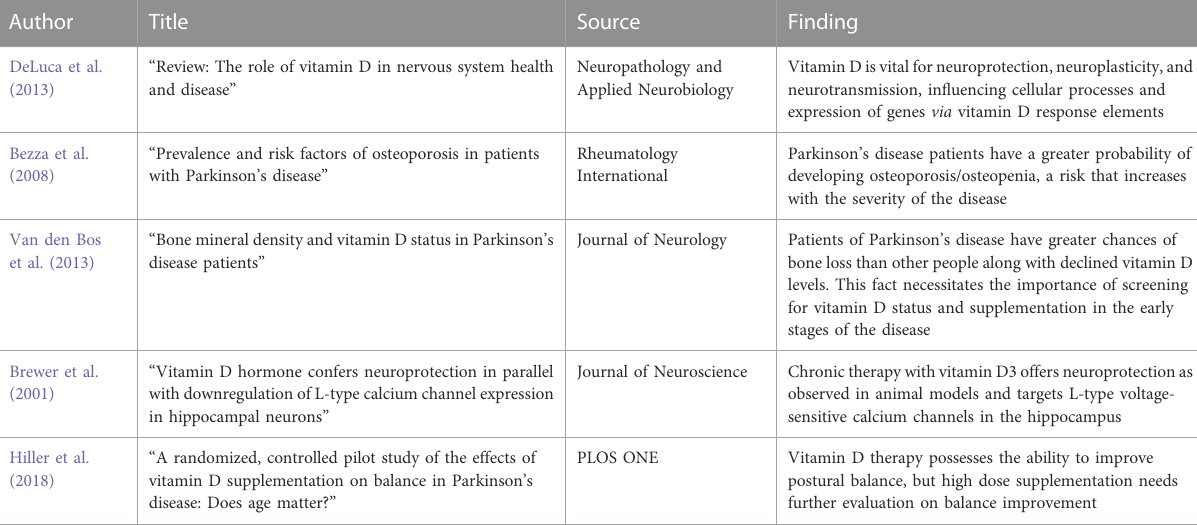
TABLE 3 Literature summary table: highlighting key points that indicate the co-relation between PD and vitamin